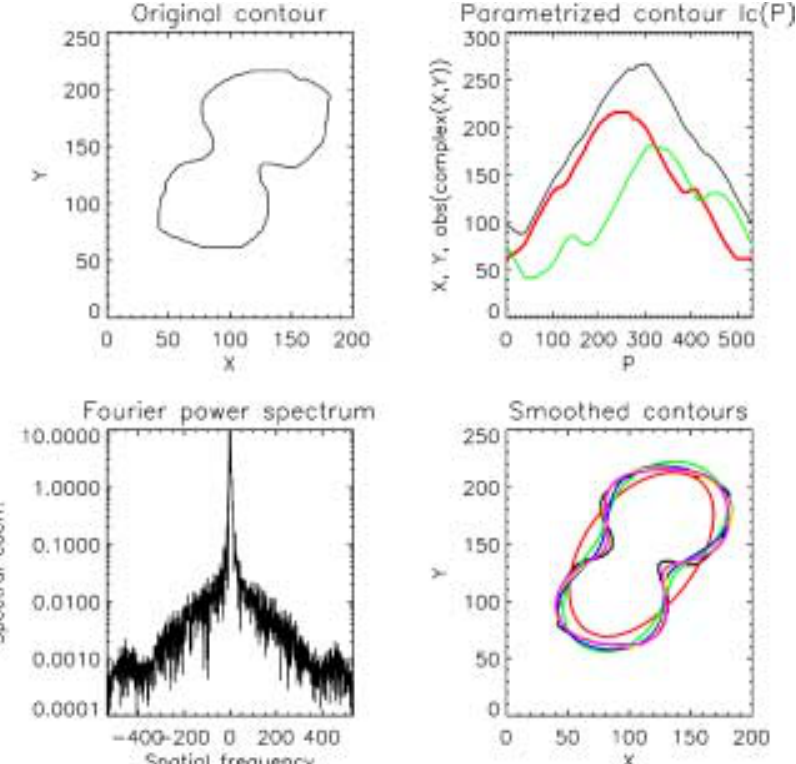
Fig. 9. Illustration of Fourier contour spectrum and its features. This figure can be viewed on http://www.esacp.org/acp/2003/25-1/ rodenacker.htm. background intensity) (Fig. 12(4 2)). The median op- erator is a special case of the rank order operators